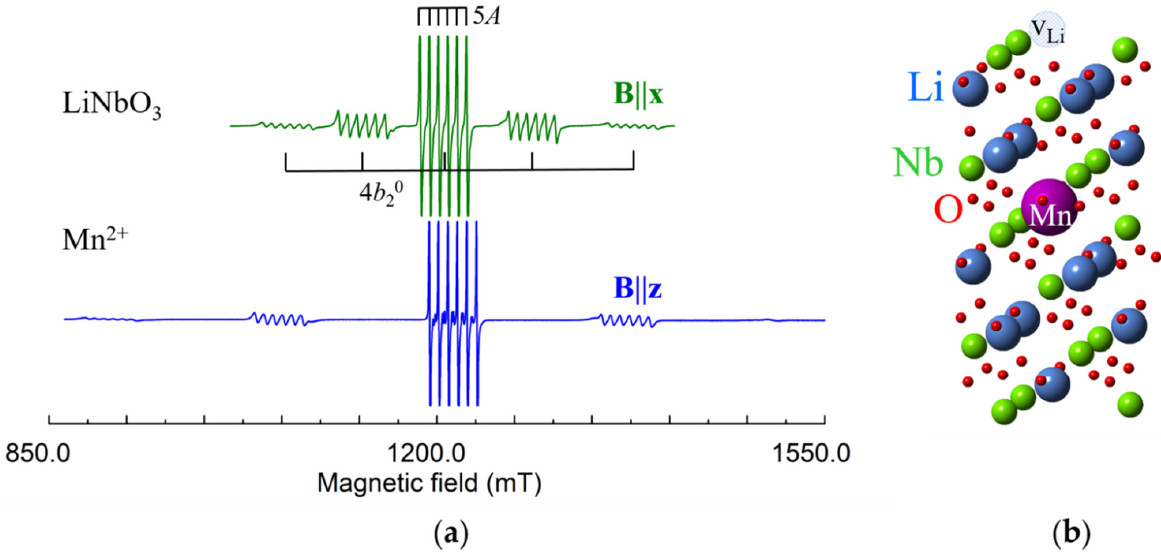
Figure 12. ( a ) Measured EPR spectrum of Mn 2+ in LN K , ν = 34.45 GHz. ( b ) Model of axial Mn 2+ Li center with v Li .